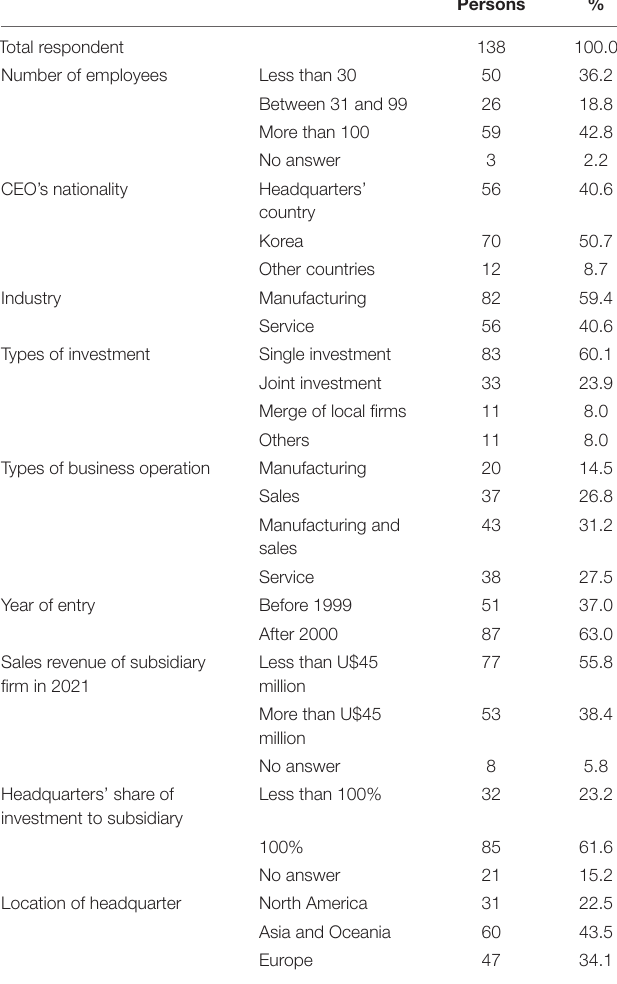
TABLE 1 | Characteristics’ distribution of the sample subsidiaries of